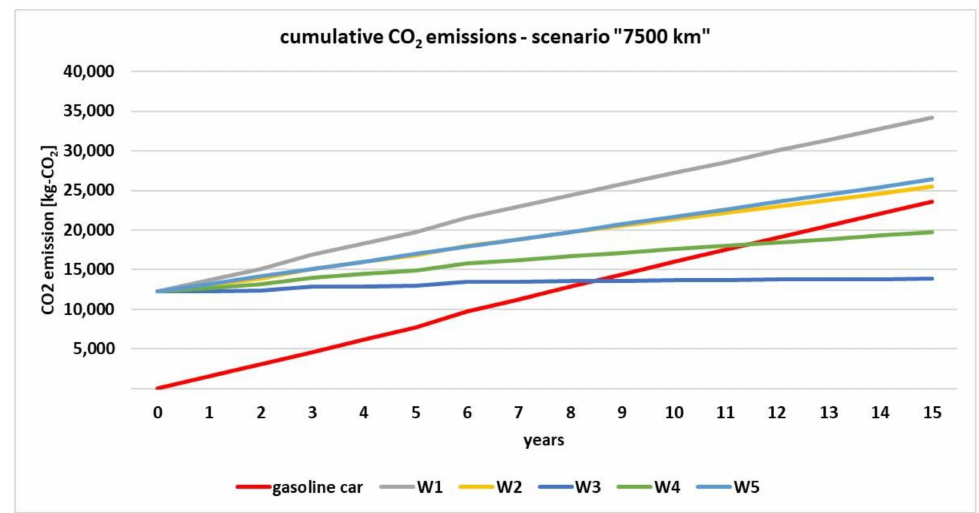
Figure 5. Comparing the cumulative CO 2 emissions for a gasoline car and an electric car in each year of operation (7500 km/year scenario).